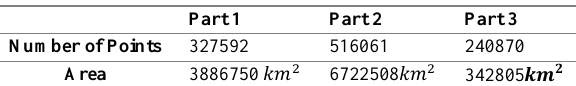
Table 1. The general properties of the dataset.